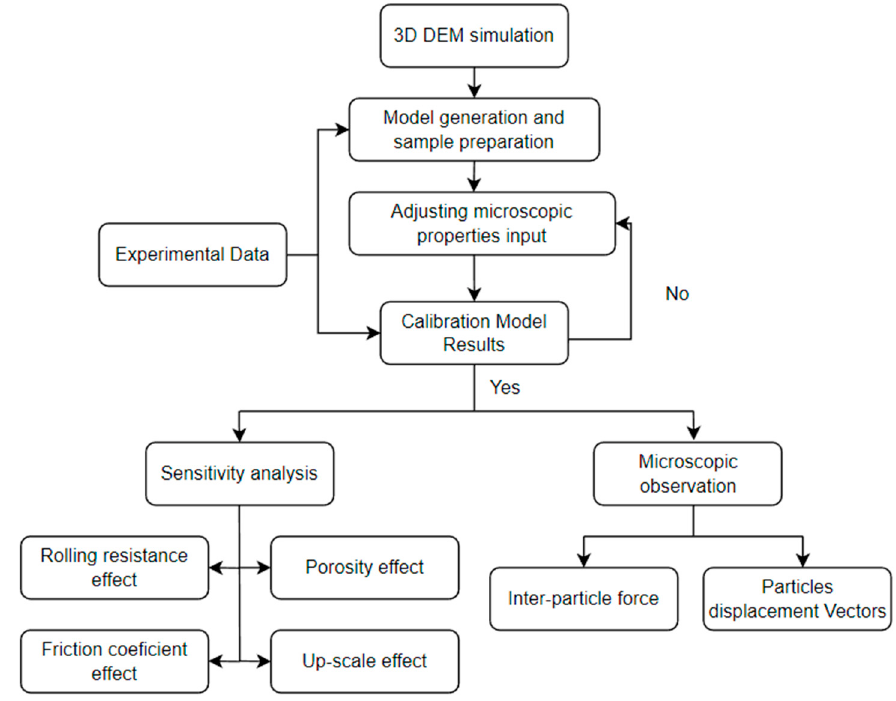
Figure 1. Flow chart of research process.